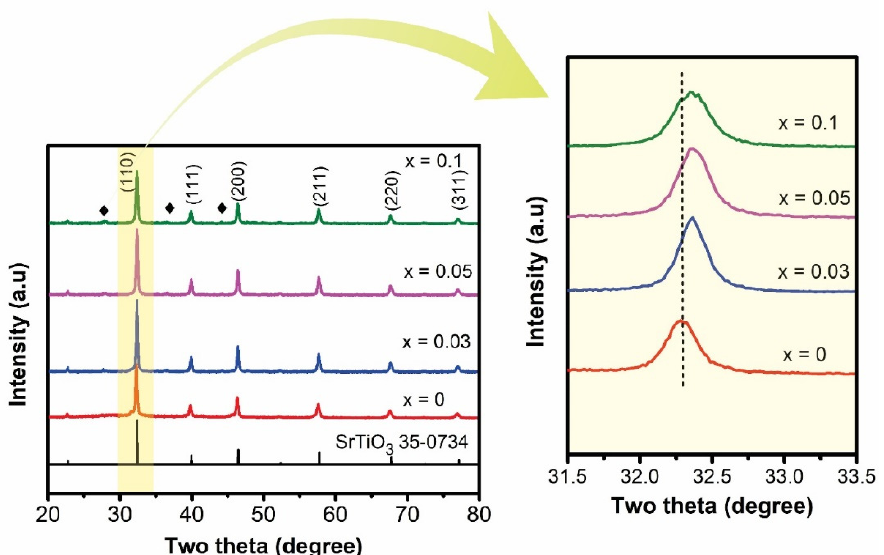
Figure 2. XRD pattern of Sr 1 − x La x TiO 3 (x = 0–0.1) photocatalysts and their zoomed section between 31.5 ° and 33.5 ° showing a peak-shift with the increased La-doping concentration.